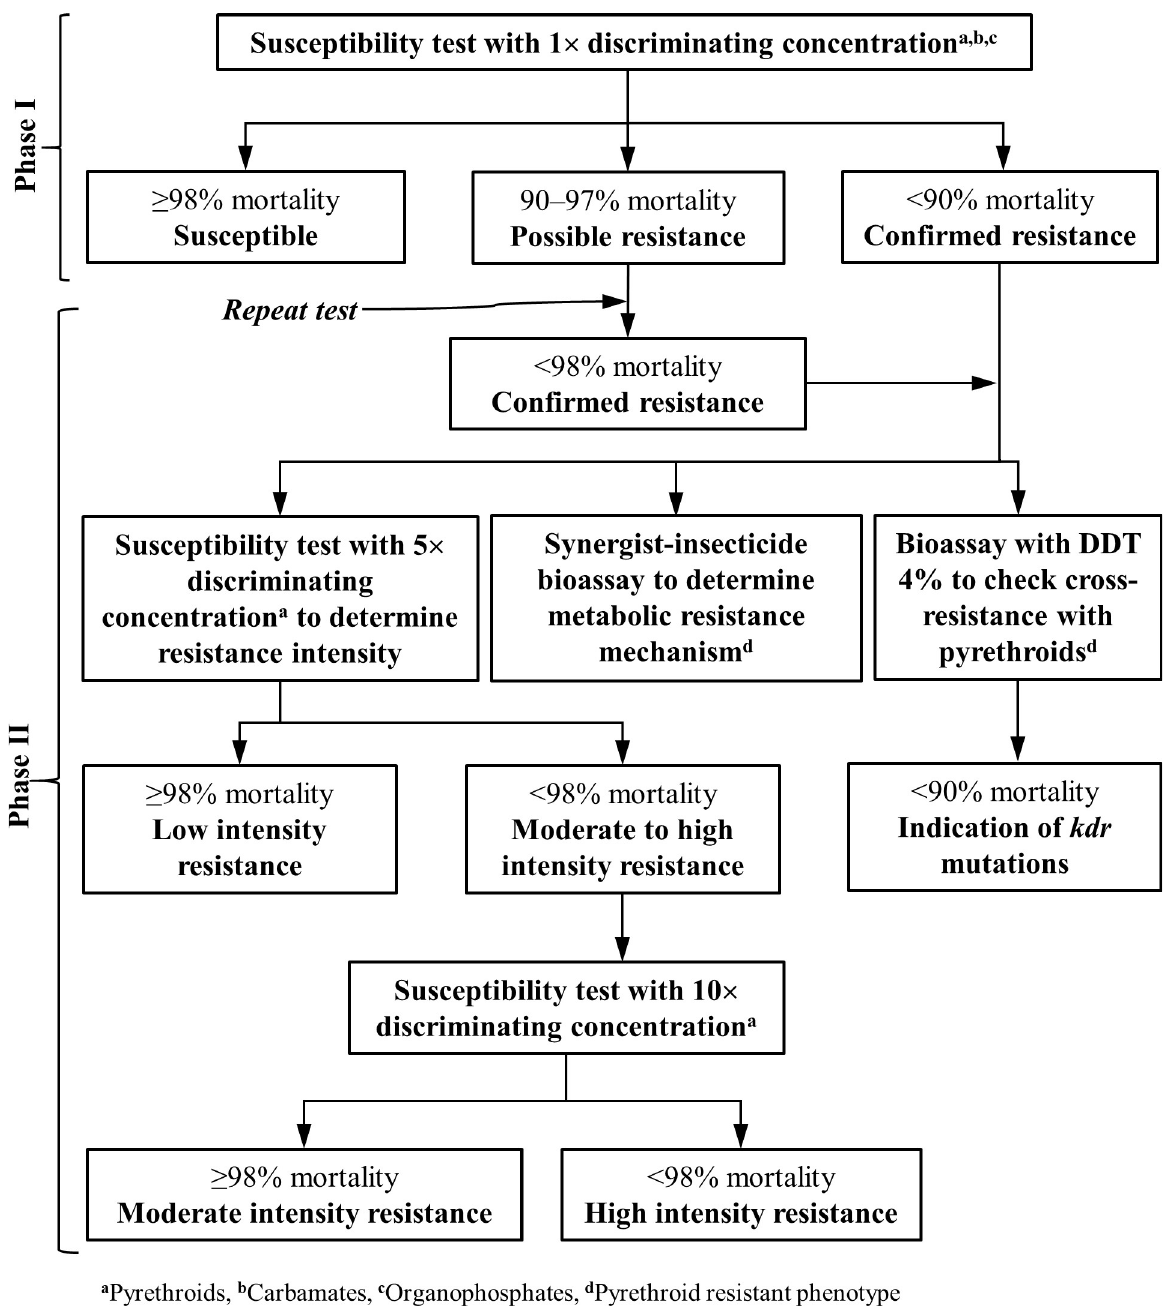
Fig 2. A graphic representation of susceptibility test sequence and probable outcomes for insecticide resistance monitoring in Phlebotomus argentipes wild populations (adopted from the WHO test procedures